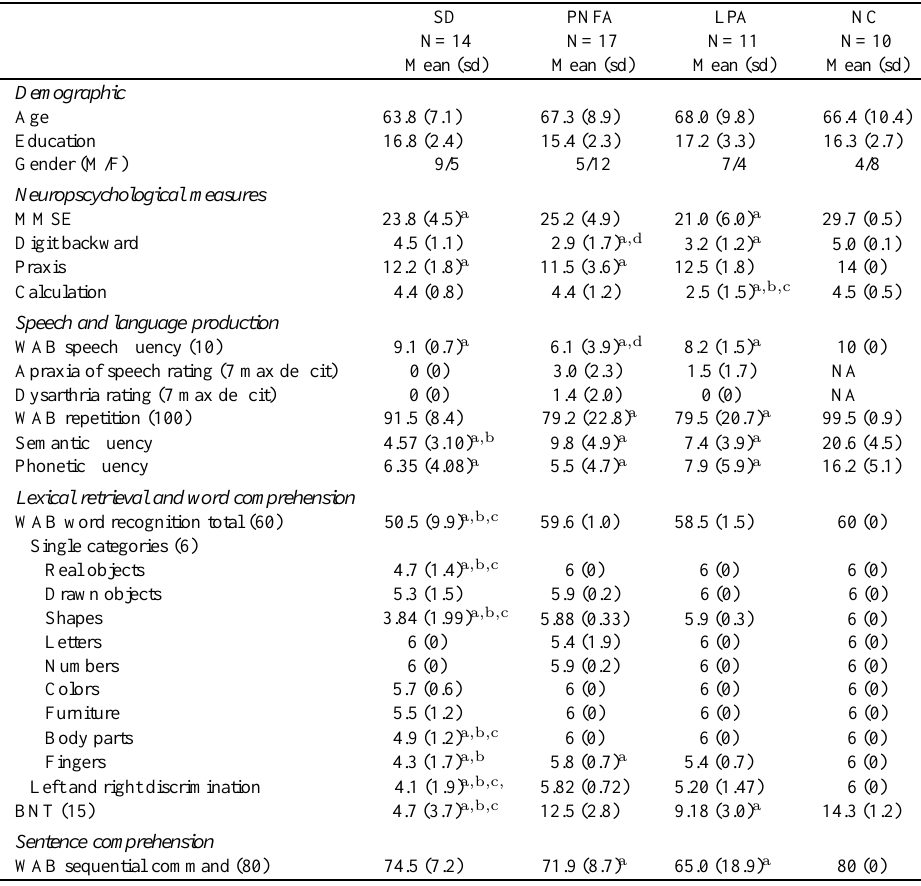
Table 2 Post-hoc analysis of neuropsychological test in the three